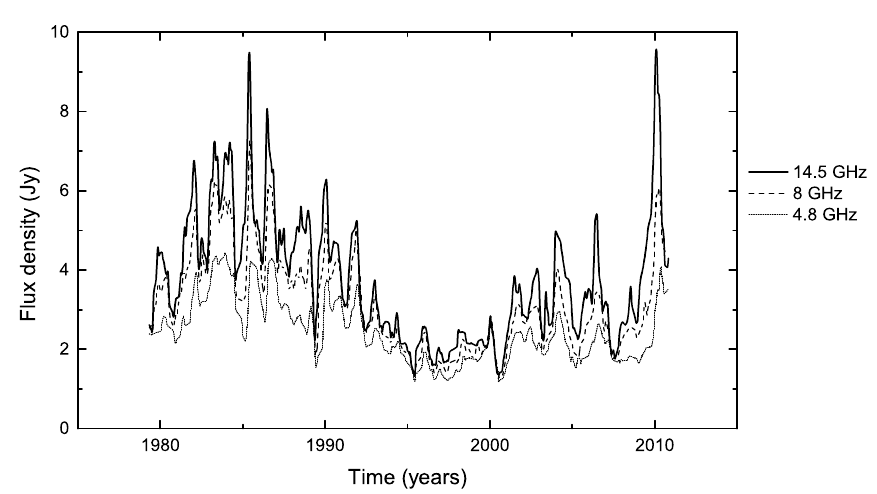
Fig. 1. Flux density of OJ 287 at the frequencies 14.5, 8.0 and 4.8 GHz. periodicity is associated with the passage of a